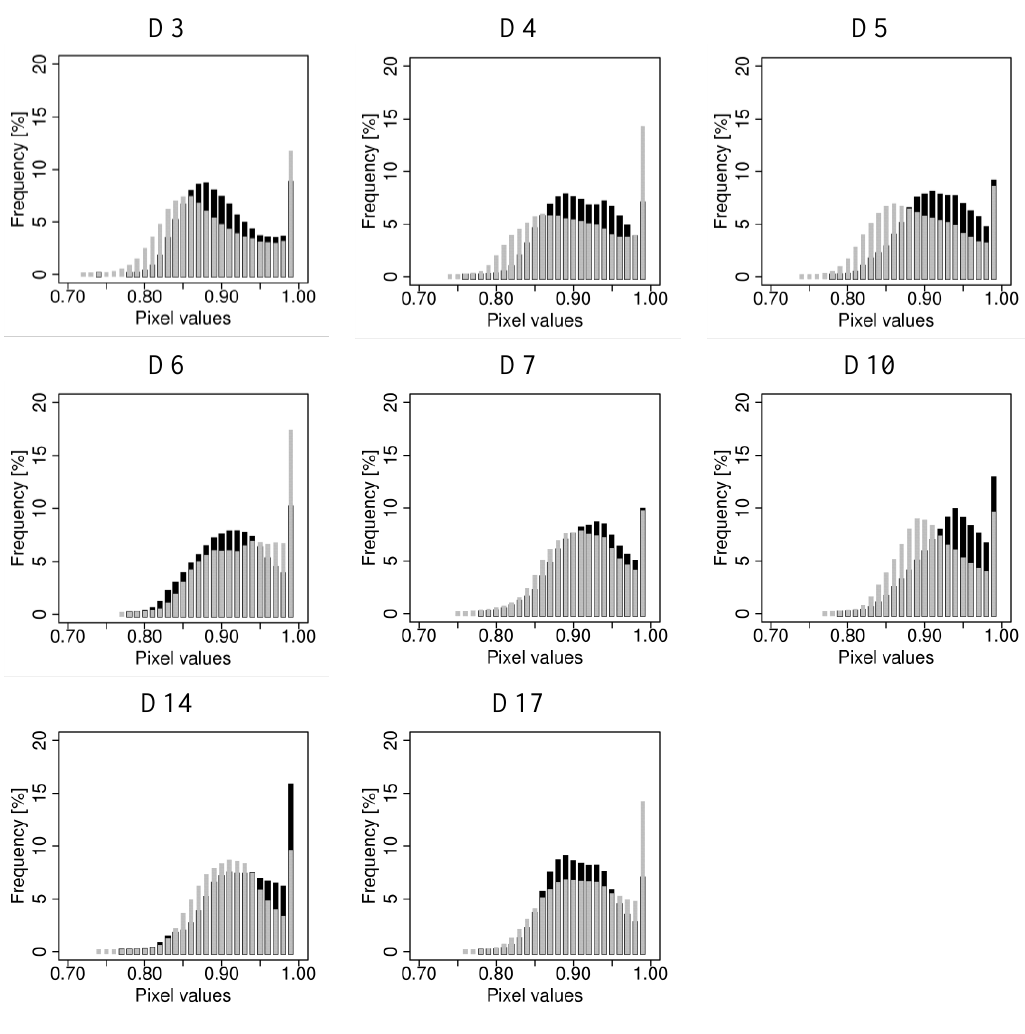
pixel values throughout time PSII